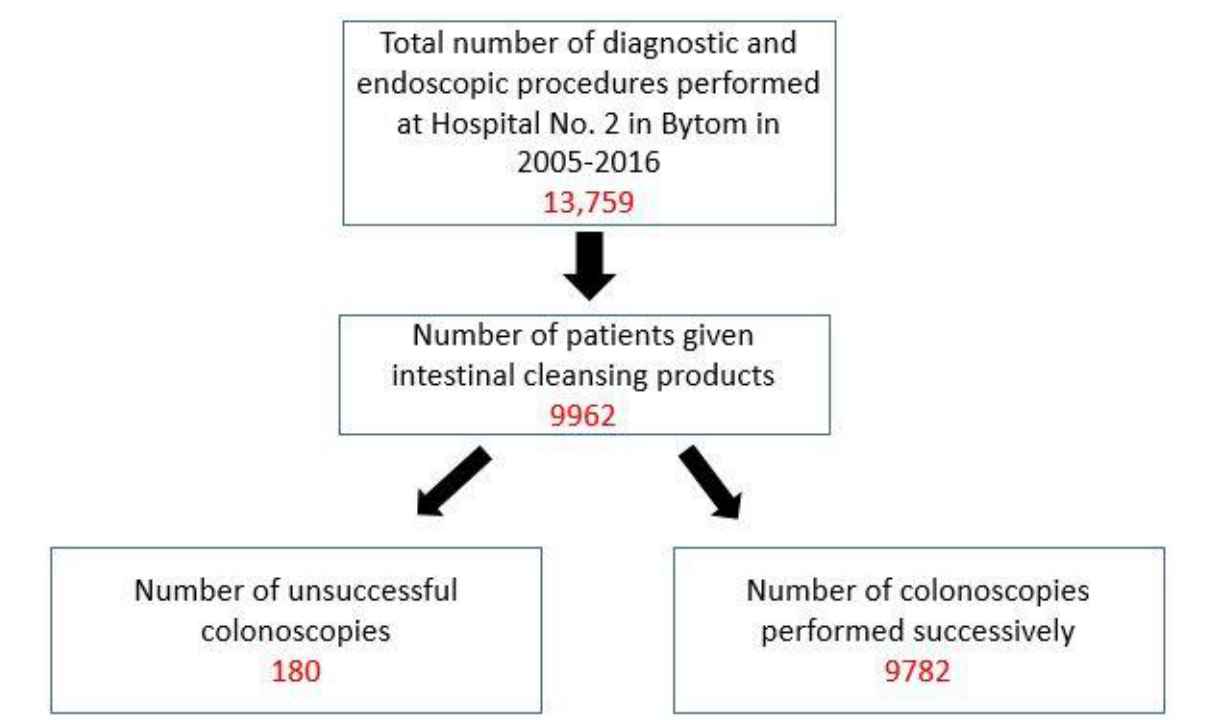
Figure 1. Diagram of performed and analyzed colonoscopy procedures.